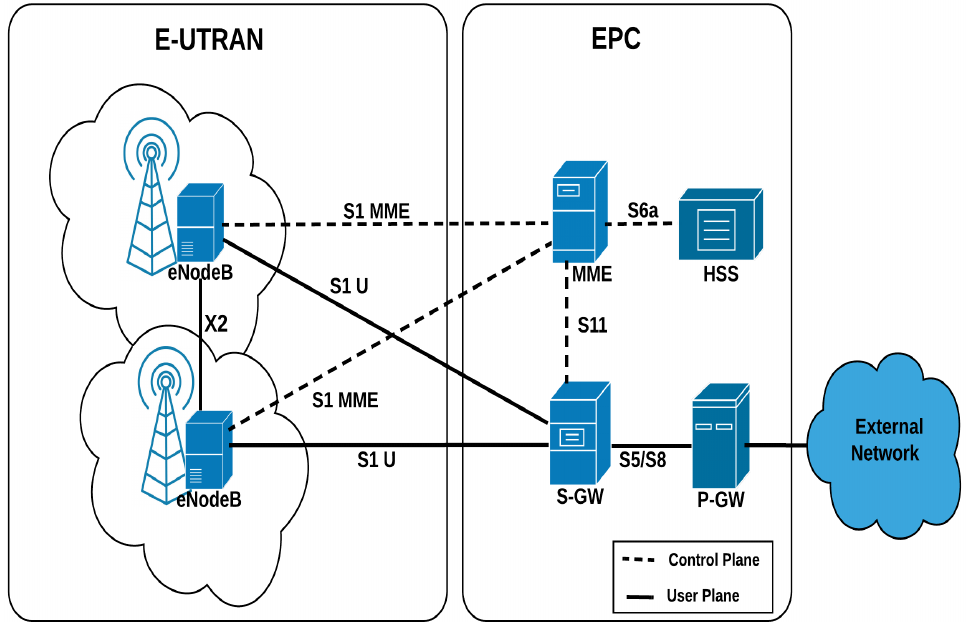
Figure 1. The Evolved Packet System (EPS) Network